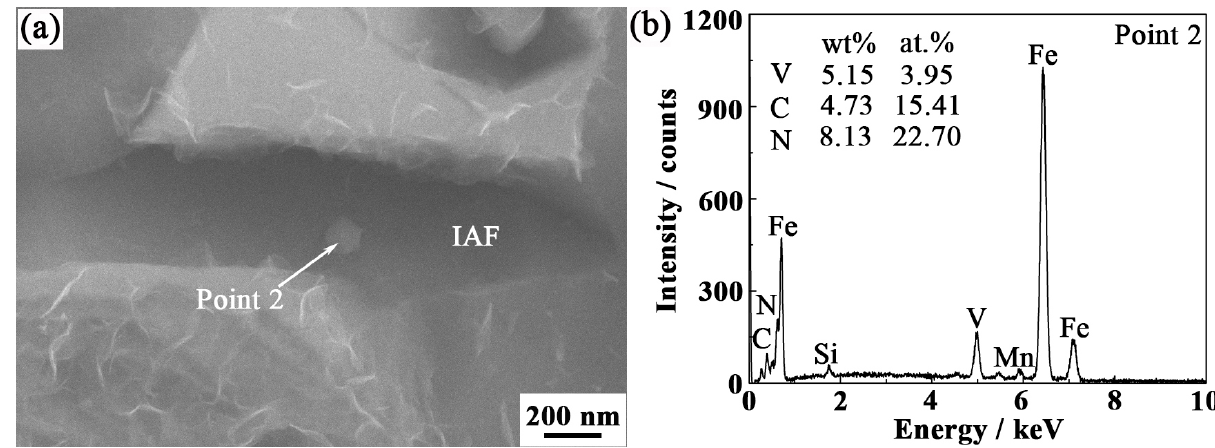
Figure 12: SEM characterization of the typical IAF and its nucleus in the simulated CGHAZ: (a) SEM image; (b) EDS